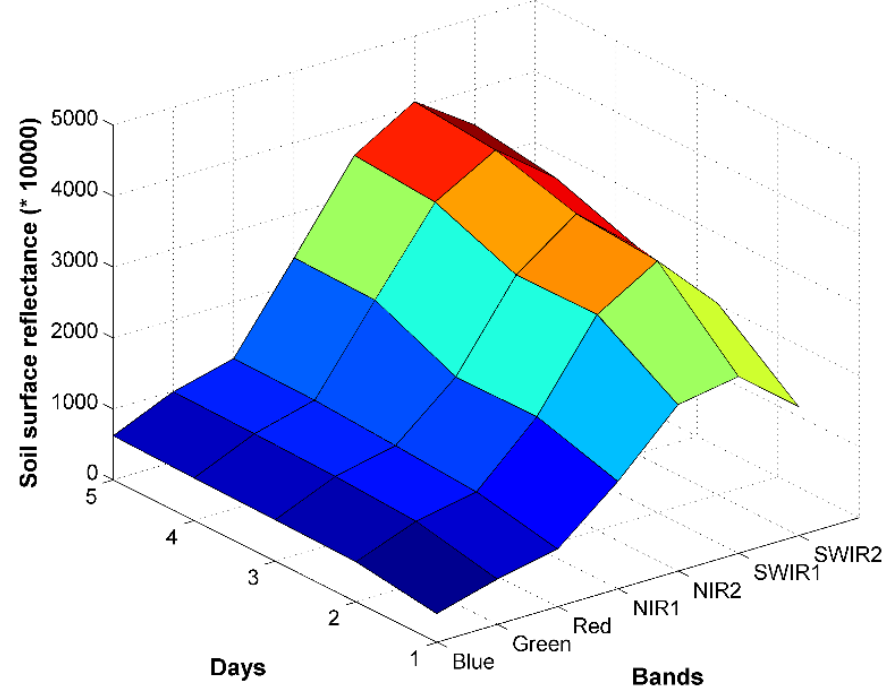
Figure 1. Dynamic soil feedback pattern at a given location in the study